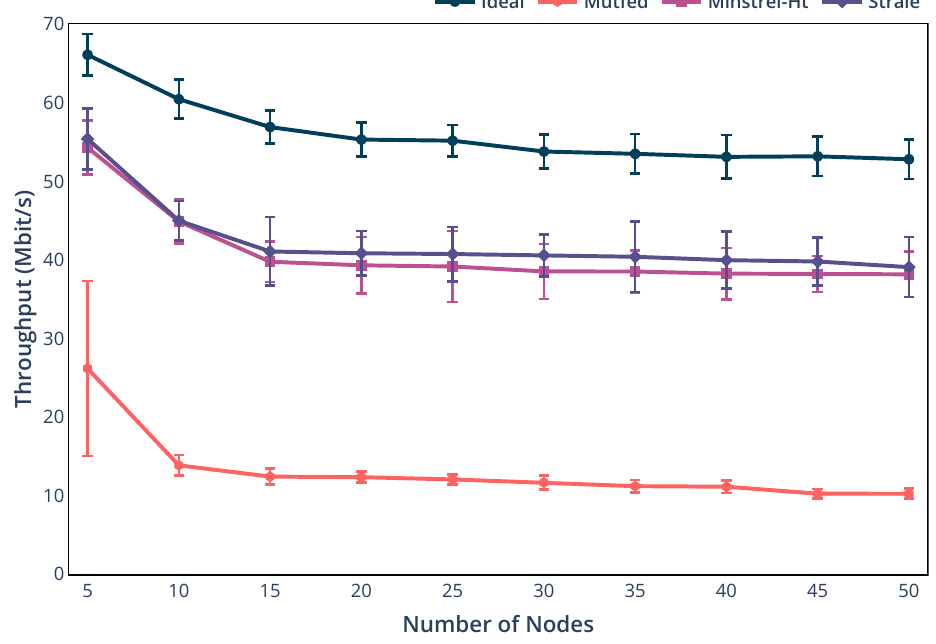
Figure 2. Overall throughput received at the access